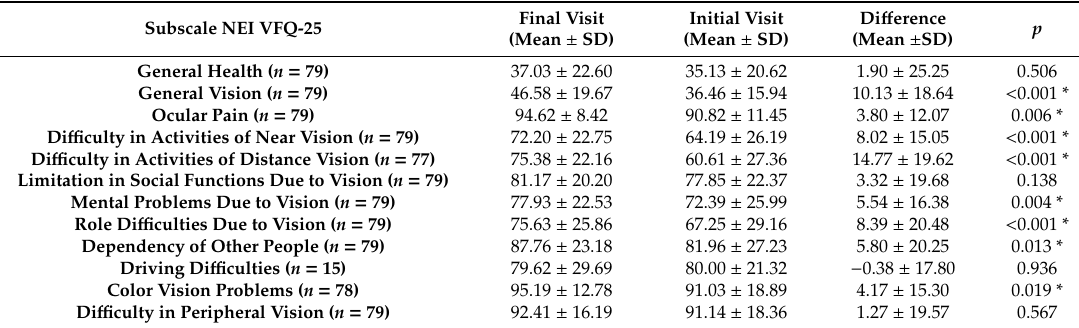
Table 3. Results of NEI VFQ-25 subscales.